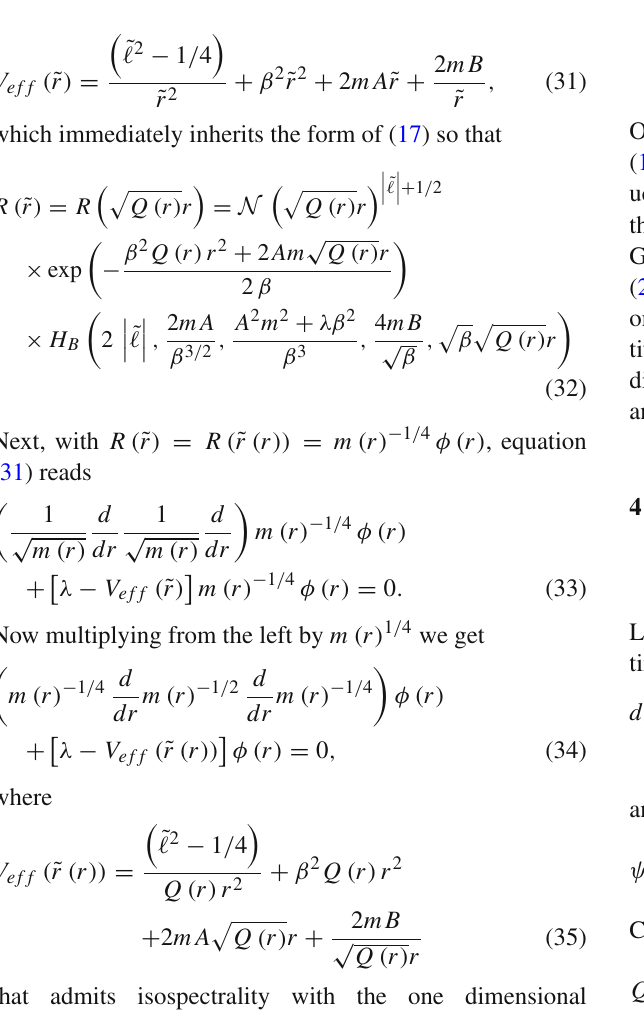
Fig. 3 For A = B = m = 1 we show the confined KG-oscillator energies E n a for ((cid:2) = 1 ,(cid:13) = 2 ) , b for ((cid:2) = − 1 ,(cid:13) = 2 ) , and c for ((cid:2) = 2 ,(cid:13) = 0